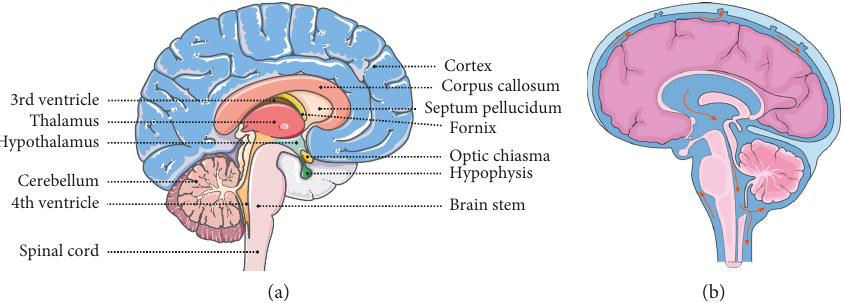
Figure 1: Comparison of normal brain and hydrocephalus brain: (a) normal brain; (b) hydrocephalus brain.